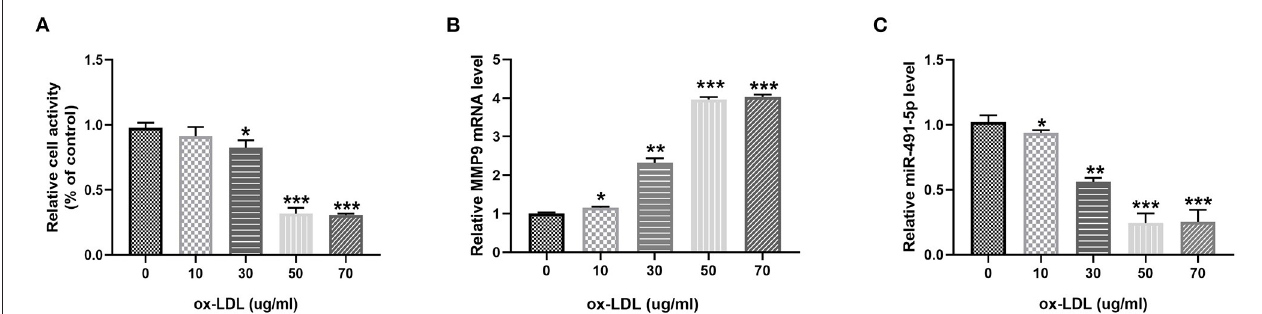
FIGURE 1 | Ox-LDL downregulated miR-491-5P and upregulated MMP-9 in THP-1 macrophages. THP-1 macrophages were induced by different concentrations (0, 10, 30, 50, and 70 µ g/mL) of ox-LDL. (A) Cell viability was determined using CCK-8. (B,C) qRT-PCR analysis measured MMP-9 level and mir-491-5p level in THP-1 macrophages stimulated with different doses of ox-LDL. Data are presented as the mean ± SD, n = 6. * P < 0.05, ** P < 0.01, and *** P < 0.001.